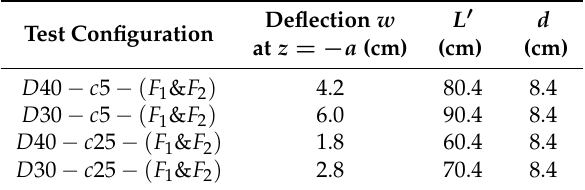
Table 3. Position Z of the base of equivalent cantilever.